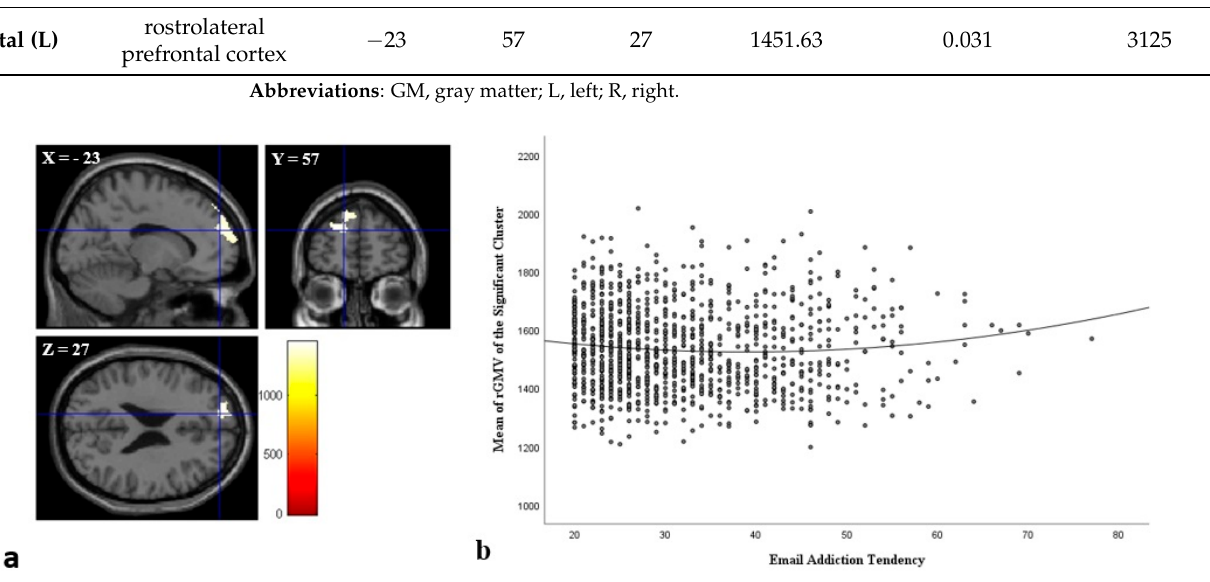
Table 3. Brain gray matter regions that have a significant positive correlation with email addiction tendency.